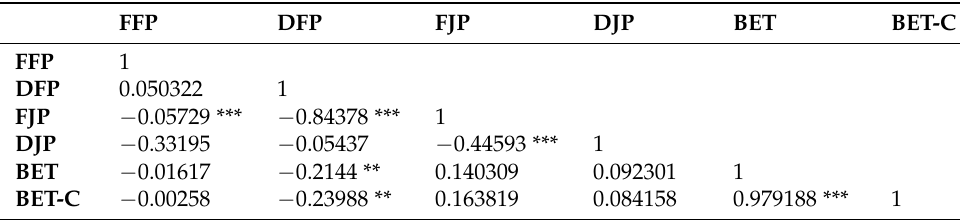
Table 3. Correlation